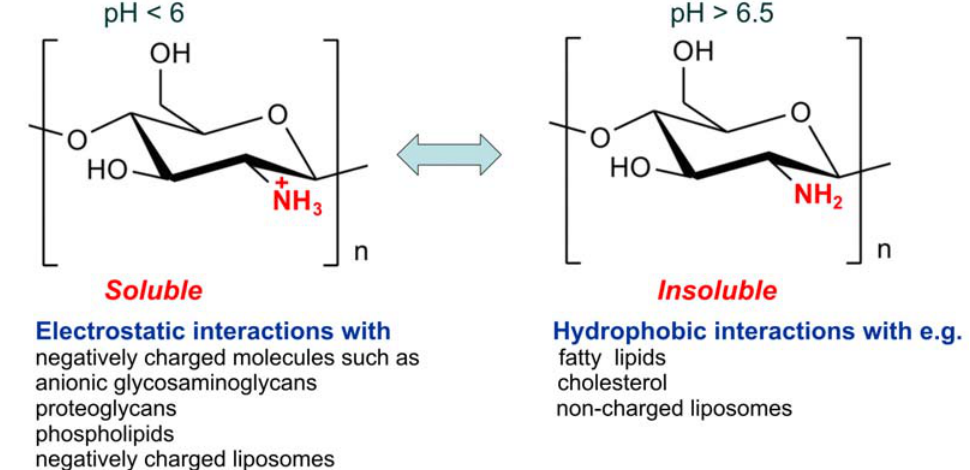
Figure 5. Schematic illustration of chitosan’s